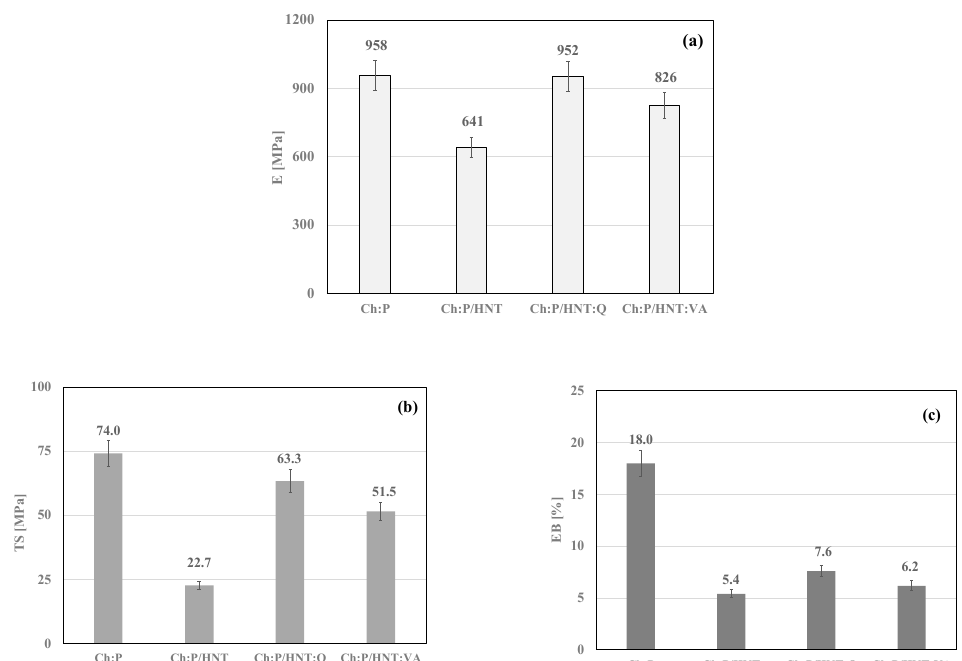
Figure 4. Main mechanical properties: ( a ) elastic modulus, E, ( b ) tensile strength, TS, and ( c ) elongation at break, EB, of Ch:P and Ch:P/HNT without and with natural antioxidants.